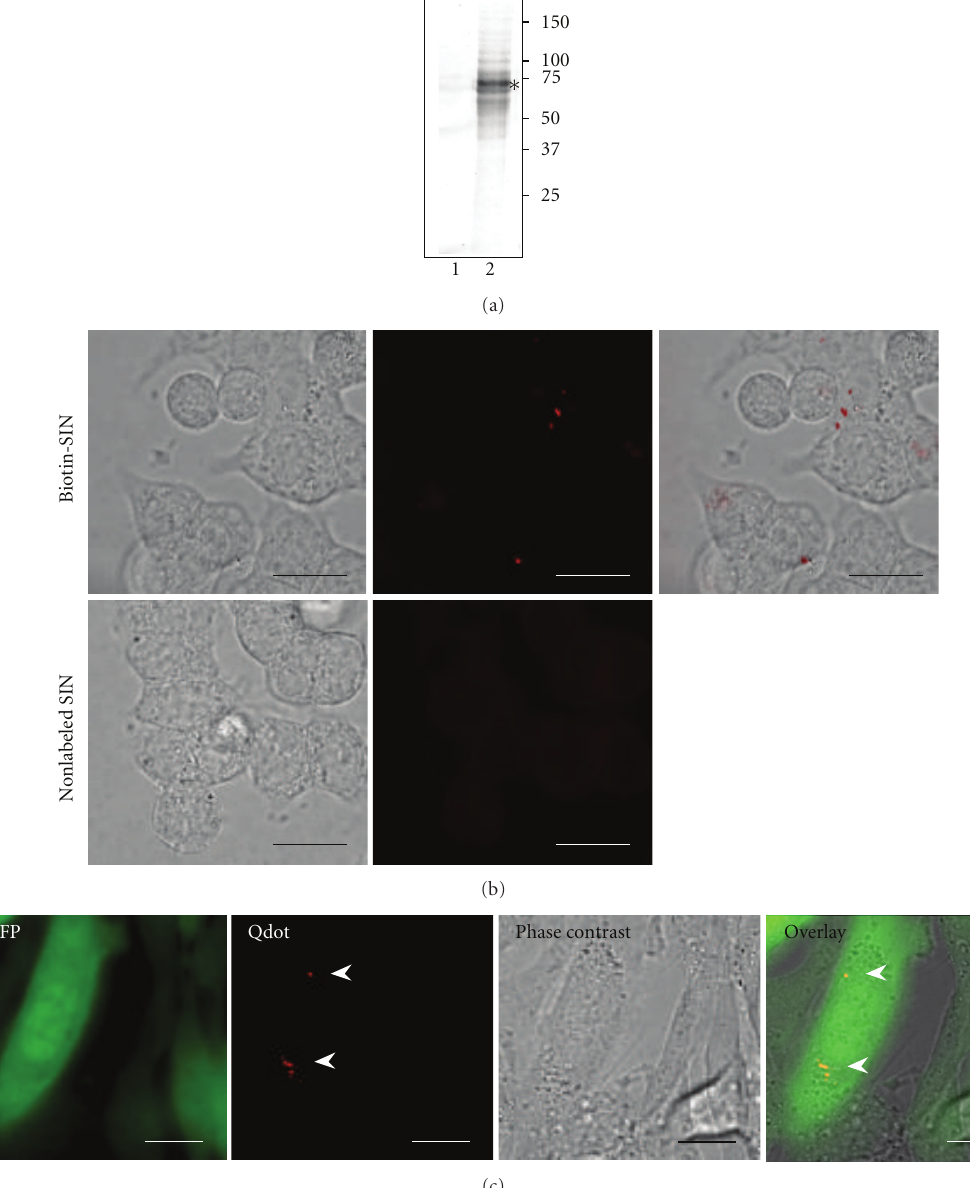
Figure 1: Biotinylation and Qdot labeling of SINV. SINV was labeled with NHS PEG4-biotin as described in Section 2. (a) Western blot analysis of biotinylated SINV using alkaline-phosphatase-conjugated streptavidin showing e ffi cient labeling of the E1/E2 envelope proteins (indicated by ∗ ). Lanes 1: control unlabeled SINV and 2: biotinylated SINV. Molecular weight markers (kD) are labeled. (b) Biotinylated SINV labeled with Qdot 605 specifically bound target cells. Arrows indicate Qdot-labeled SINV. Bar = 25 µ m. (c) Biotinylated SINV labeled with Qdot 605 was active infecting target cells and expressing GFP. Images were taken 14 hours after infection. Arrowheads indicate Qdot signals. Bar = 25 µ